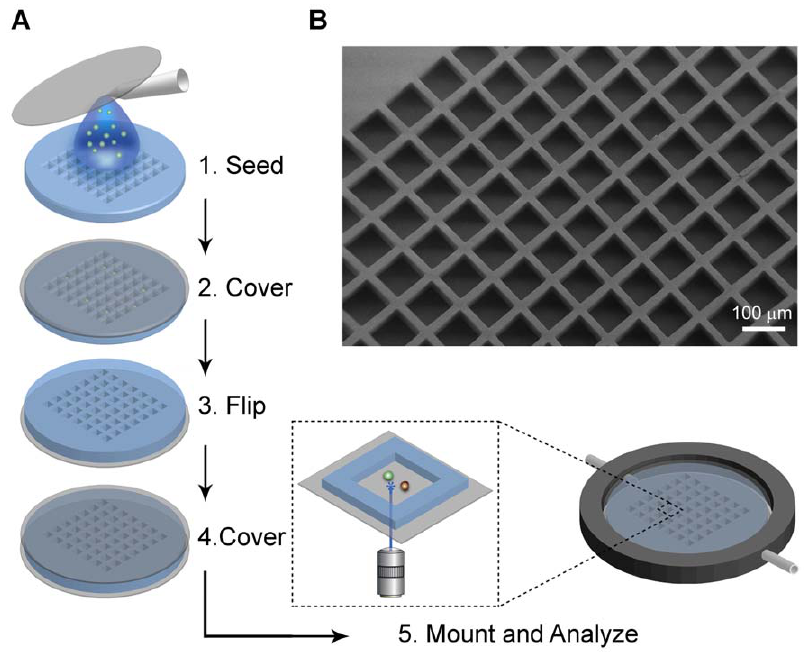
Figure 1. Preparation of PDMS chips for microscopy. (A) Schematic drawing demonstrating chip preparation from seeding to microscopy. Cell suspension was added onto the primed chip (1), excess medium was removed, and the wells were sealed with a cover glass to confine the cells (2). Chip was turned up-side-down (3) and another cover glass was added to increase stability (4). Finally, the chip was mounted in holder and imaging was performed with an inverted microscope to allow high-resolution imaging (5). Illustrations are not to scale. (B) Scanning Electron Microscopy (SEM) image showing the well structure on the chip.